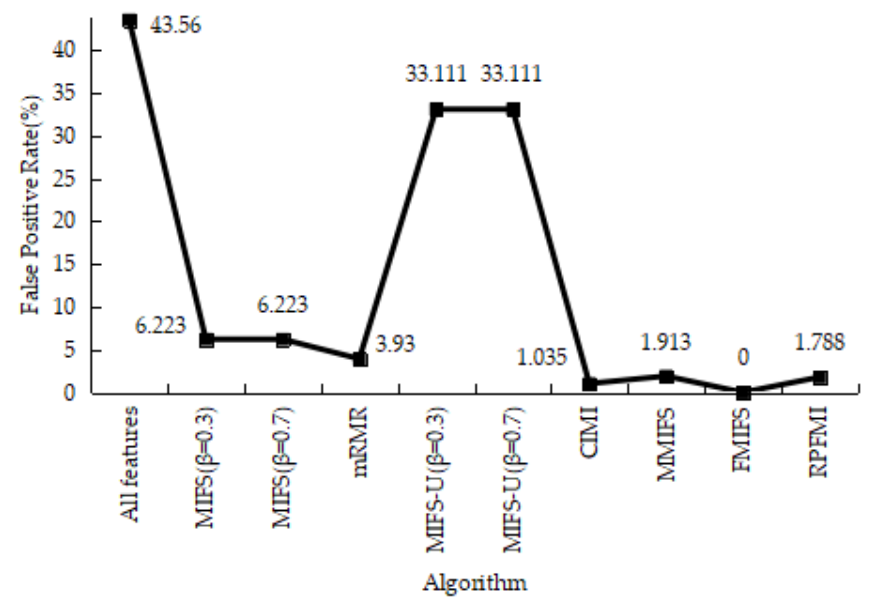
Figure 15. False Positive Rate on the Kyoto 2006+ test data.